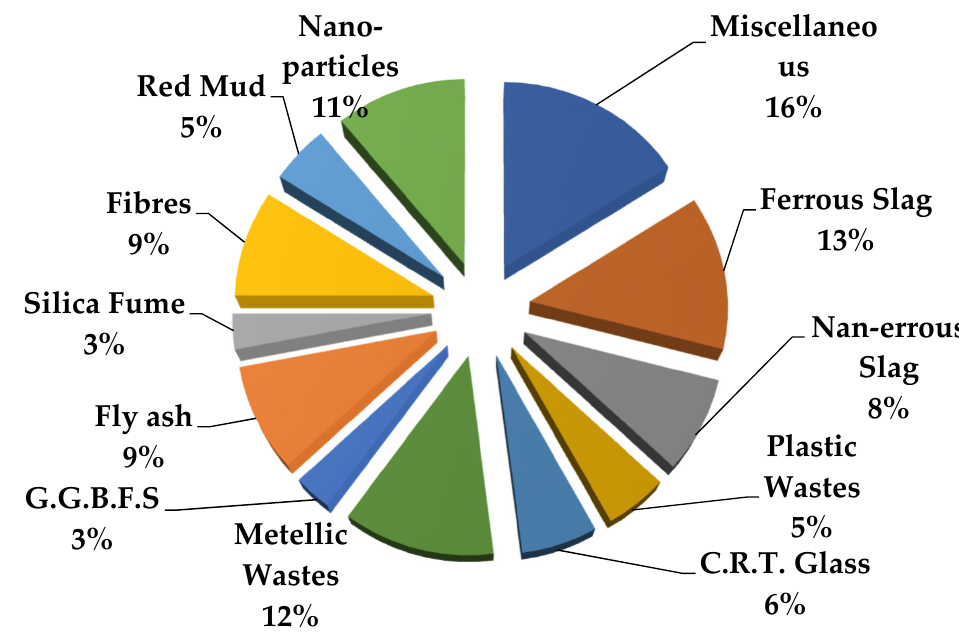
Figure 4. Percentage of the distribution of alternative materials’ usage in RSC.